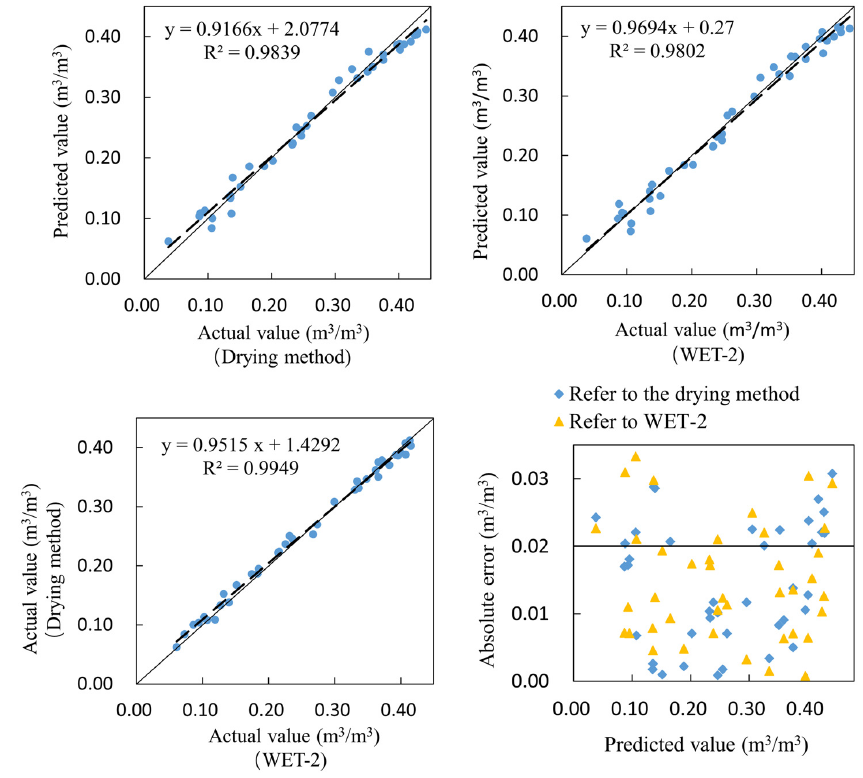
Figure 21. Sensor laboratory accuracy veri fi cation.